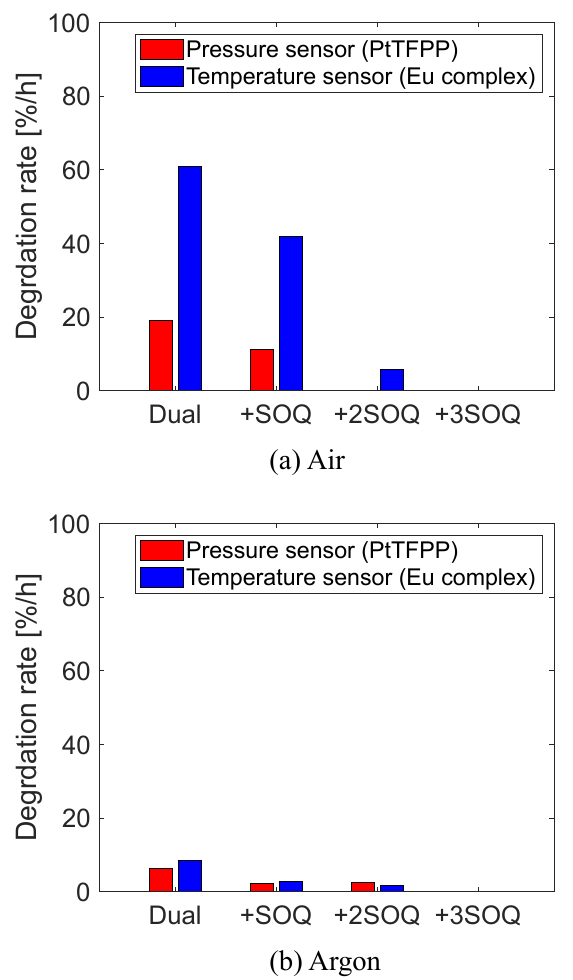
Figure 6. Effects of SOQ concentration on degradation rate.